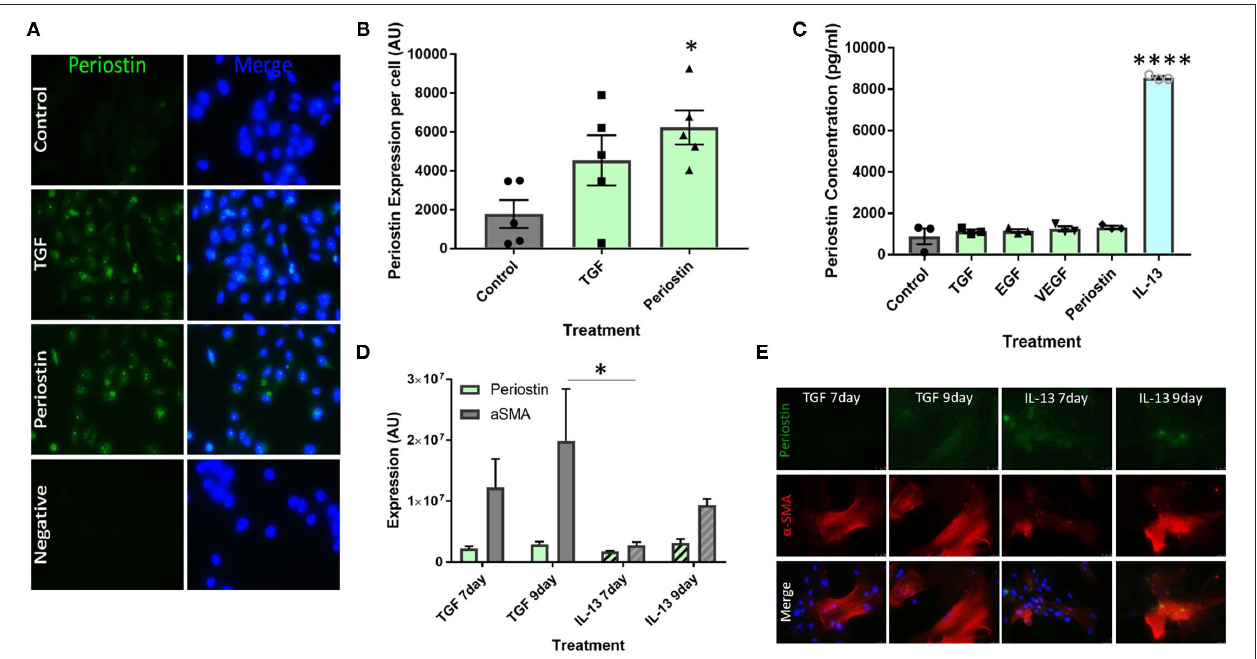
FIGURE 2 | Type 2 inflammatory mediators stimulate periostin expression by pericytes. (A,B) Immunostaining performed on pericytes grown in pericyte medium and treated with 10ng/ml of TGF- β or 100ng/ml of periostin for 24h. Cells were stained with an anti-periostin antibody (green) and the nuclear stain DAPI (blue). Images were taken at 400x magnification and intensity of periostin stain was calculated with ImageJ. Intensity of stain per field of view was divided by the number of cells in order to determine periostin expression per cell. * p < 0.05, n = 5 representative of two independent experiments. (C) Cultured pericytes were treated with 10ng/ml TGF- β , 10ng/ml EGF, 10ng/ml VEGF, 100ng/ml IL-13 or 100ng/ml Periostin in pericyte medium for 7 days before the supernatant was harvested. The periostin content was assessed using an anti-periostin ELISA kit. **** p < 0.0001, n = 3 representative of two independent experiments. (D,E) Cultured pericytes were treated with 10ng/ml TGF- β or 100ng/ml IL-13 for either 7 or 9 days. Cells were stained with an anti-periostin antibody and an anti- α SMA antibody. The images were taken at 400x magnification and quantifications were made using ImageJ. * p < 0.05, n = 3–4 representative of two independent